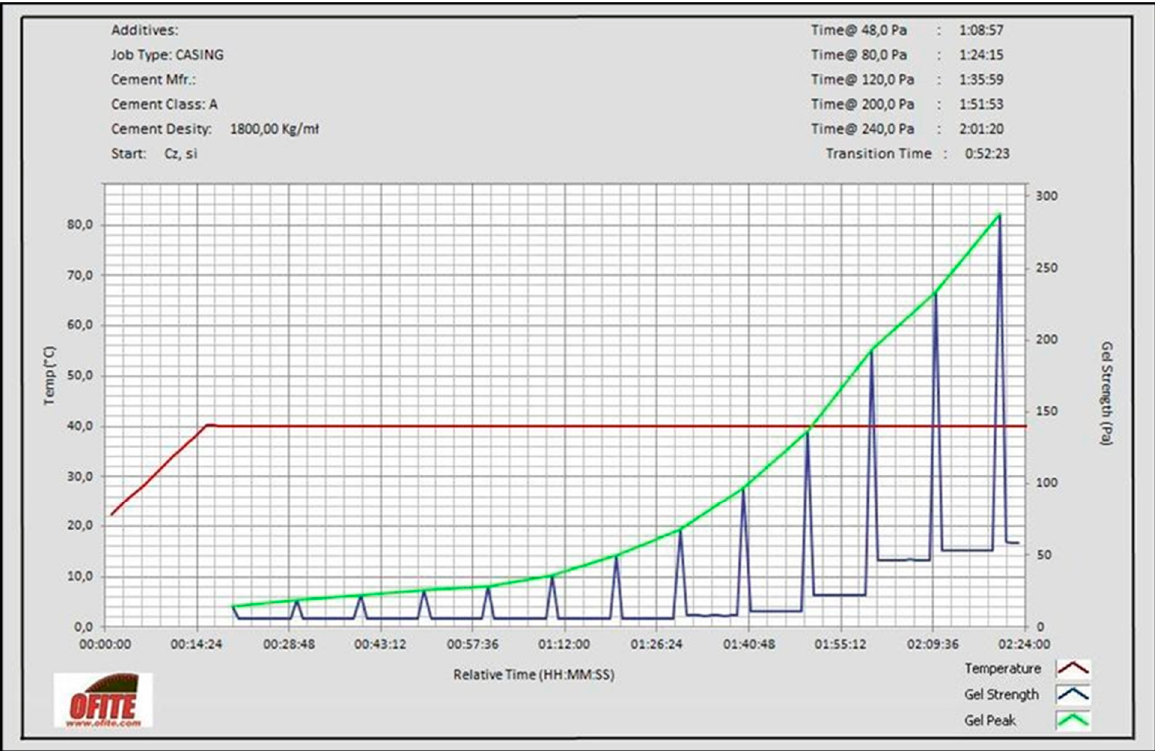
Figure 9. Course of the gas migration test during setting for slurry with high anti-migration resistance.